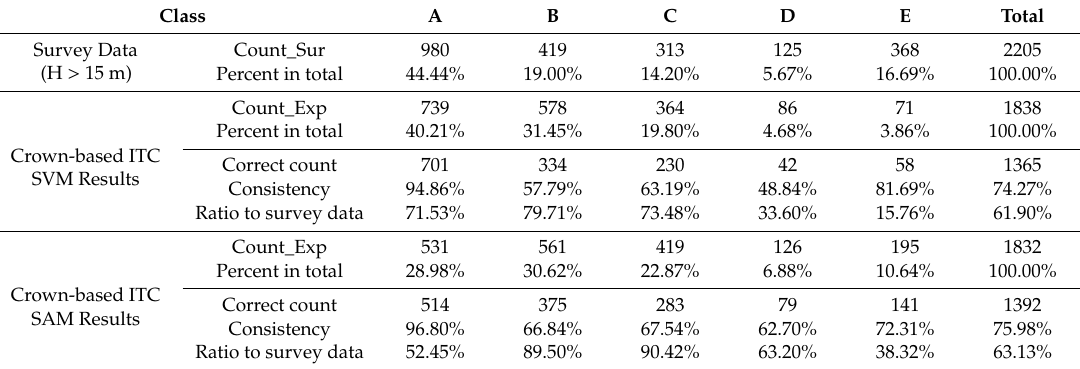
Table5. Consistencyresultstatisticsforcrown-basedITC(Count_Sur: CountofSurveydata, Count_Exp: Count of Experiments, Percent in total: ratio of count to total, A–E are classes).